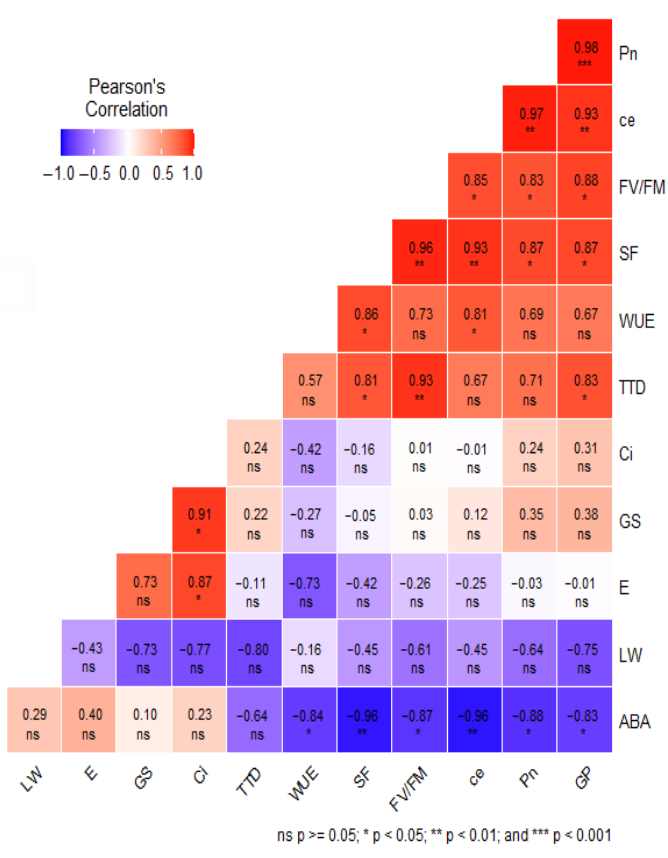
Figure 8. Pearson correlation matrix for physiological and grain yield traits in ambient-temperature (AT) and high-temperature (HT) treatments. ***, **, * correlation is significant at the 0.001, 0.01 and 0.05 level, respectively, with photosynthetic rate (Pn), transpiration rate (E), stomatal conductance (g s ), substomatal CO 2 concentration (Ci), photosynthetic water use efficiency (pWUE), carboxylation efficiency (CE), photosystem II efficiency (Fv/Fm), tissue temperature depression (TTD), abscisic acid content (ABA), leaf width (LW), spikelet fertility (SF) and grain yield per plant (GP).